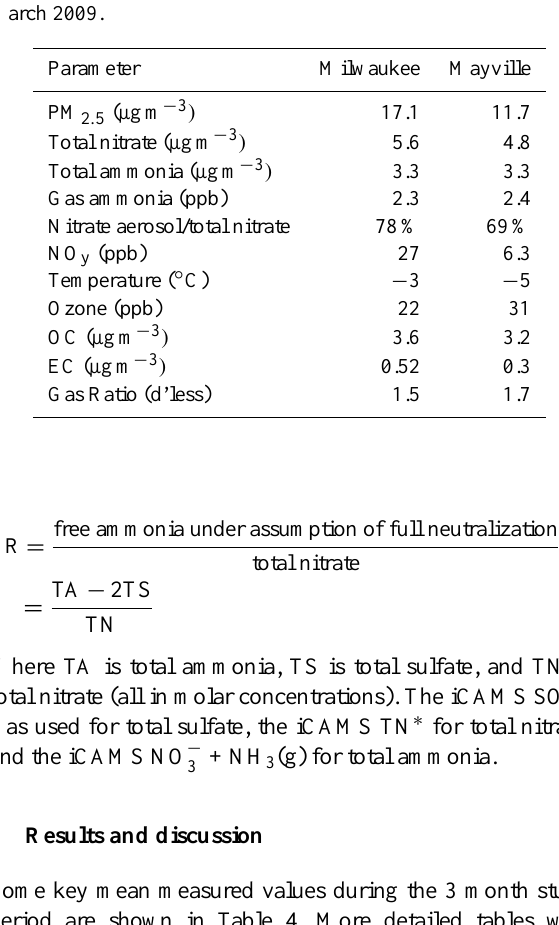
Table 4. Key mean measured values during the period 1 January–31 March